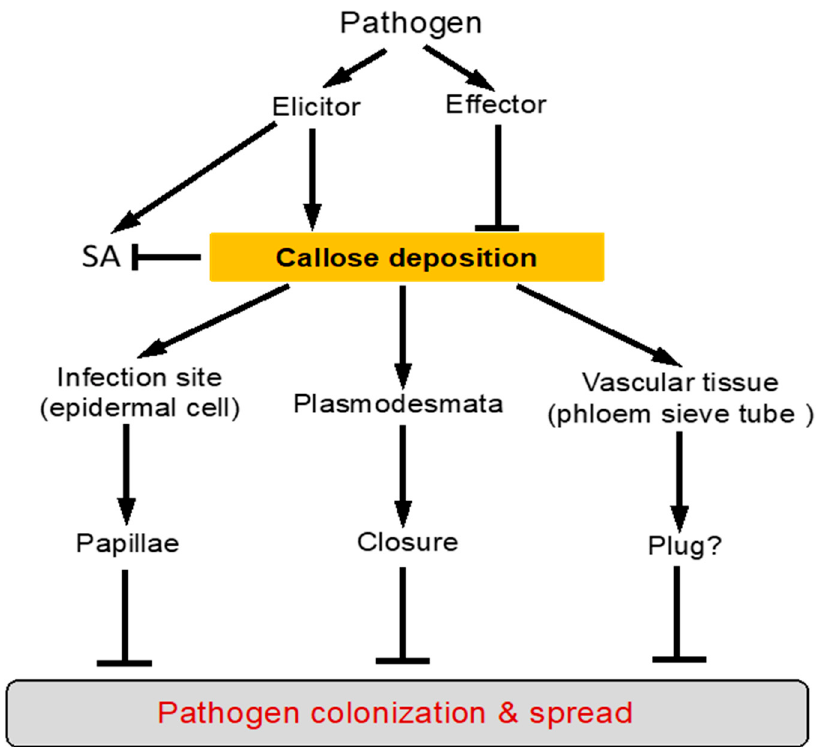
Figure 3. Induction and roles of defense-related callose deposition in plants. Pathogen elicitor- activated signaling of plant innate immune responses leads to increased callose deposition at the sites of pathogen attack, at plasmodesmata and in the vascular tissues. Formation of callose-rich papilla at the infection sites helps restrict penetration and colonization by invading pathogens. Increased callose deposition at plasmodesmata leads to plasmodesmata closure, which helps restrict pathogen spread. Increased callose deposition in the vascular tissues such as phloem sieve tubes could also functions as a defense mechanism for reducing the colonization and transport of vascular pathogens. In Arabidopsis , pathogen-induced SA signaling is negative regulated by PMR4-dependent callose deposition. Pathogens contain effector proteins that inhibit or block defense-related callose deposition as counter-defense mechanisms.